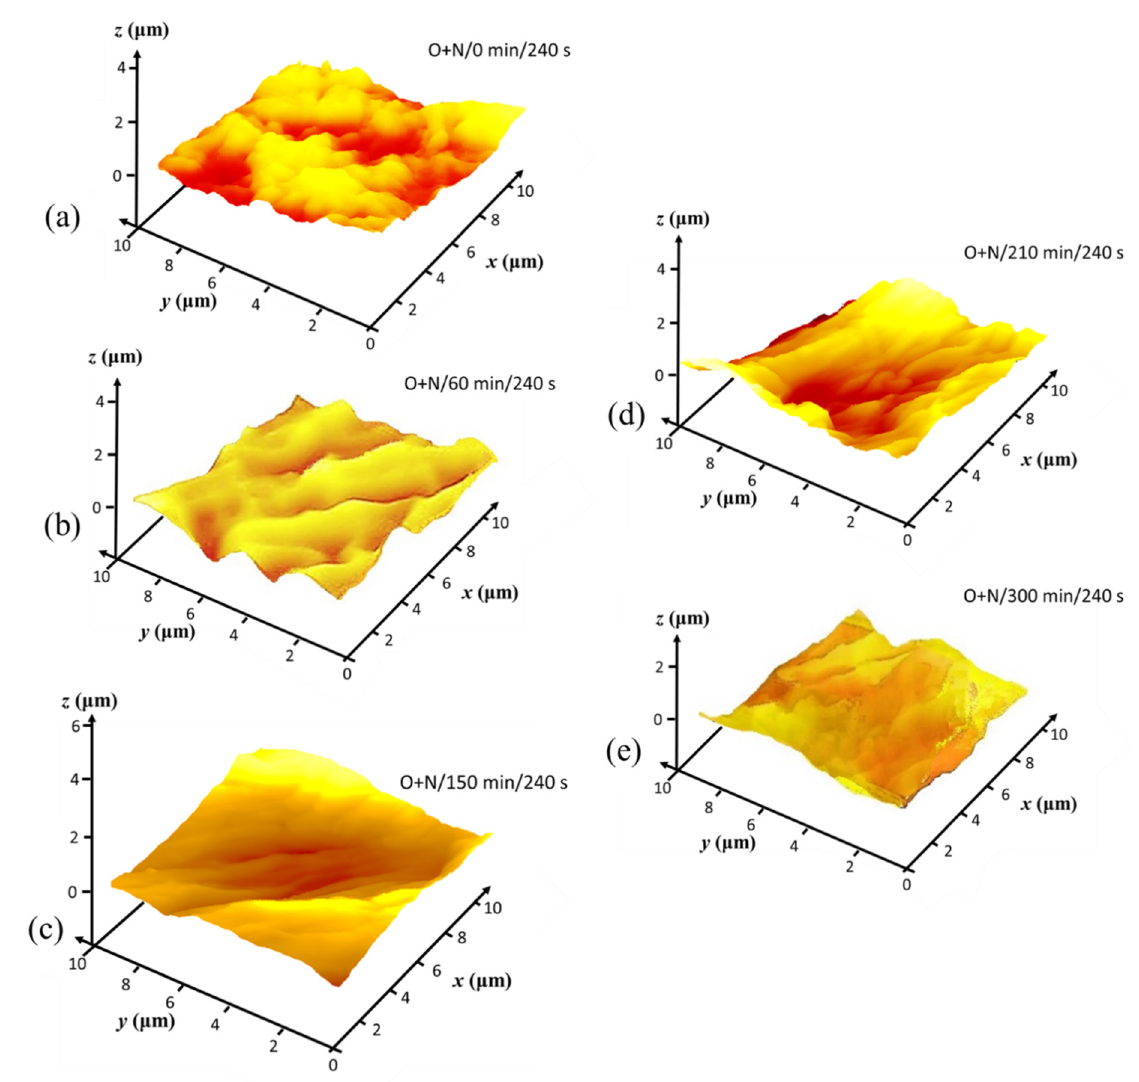
Figure 14. AFM surface profile plots showing the impact of combined 120 s oxygen followed by 120 s nitrogen plasma exposure in balance with the initial progressively improved smoothness after enzymatic pretreatment: ( a ) 0 min, ( b ) 60 min, ( c ) 150 min, ( d ) 210 min, and ( e ) 300 min, respectively.